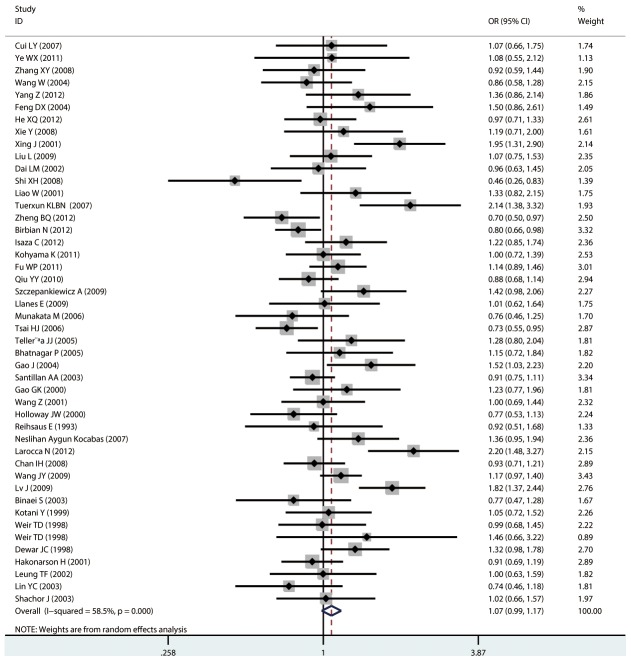
Forest plots of the association between the Arg16Gly (rs1042713) polymorphism and risk of asthma in allele comparison.